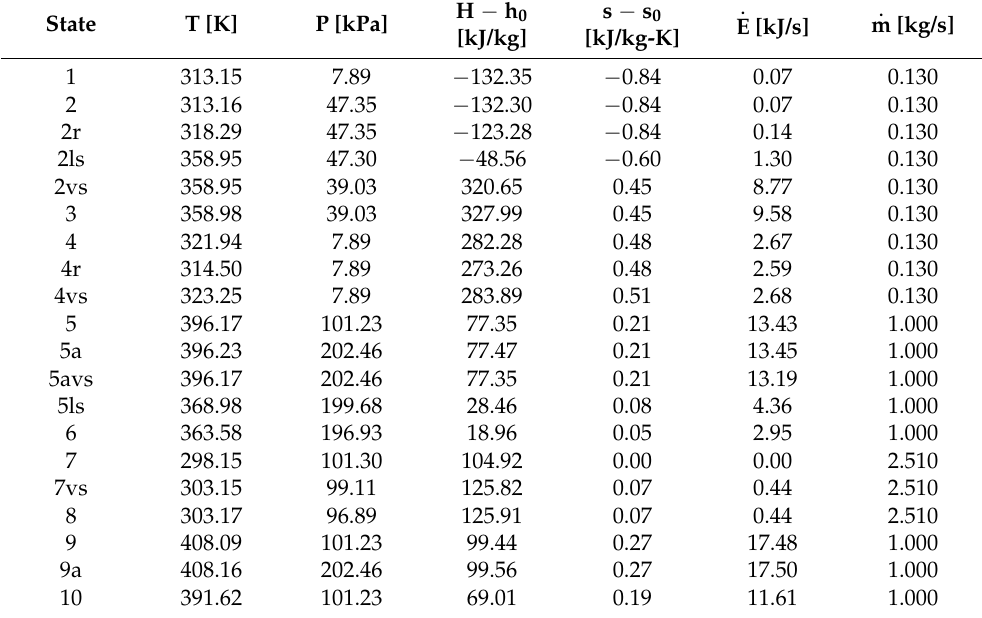
Table 4. Thermodynamic properties of RORC–Solar